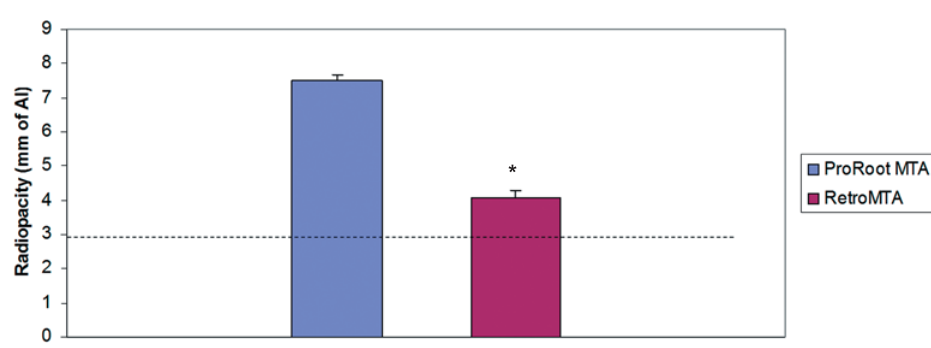
Figure 2- Radiopacity of ProRoot ® MTA and RetroMTA ® in mm of Al. Dashed line represents the radiopacity of 3 mm of Al as recommended by ANSI/ADA No. 57 2